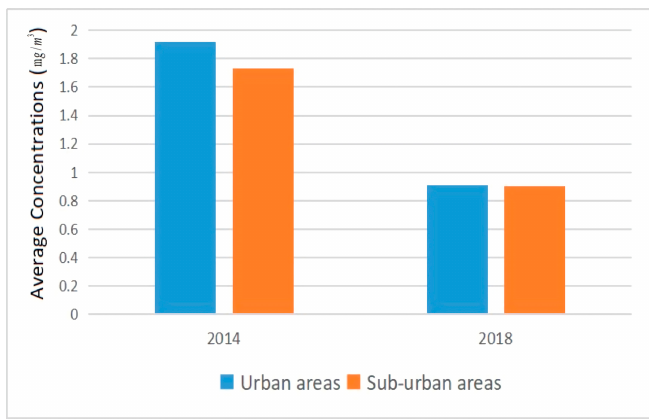
Figure 2. Average concentrations of CO between urban and sub-urban areas in 2014 and 2018.